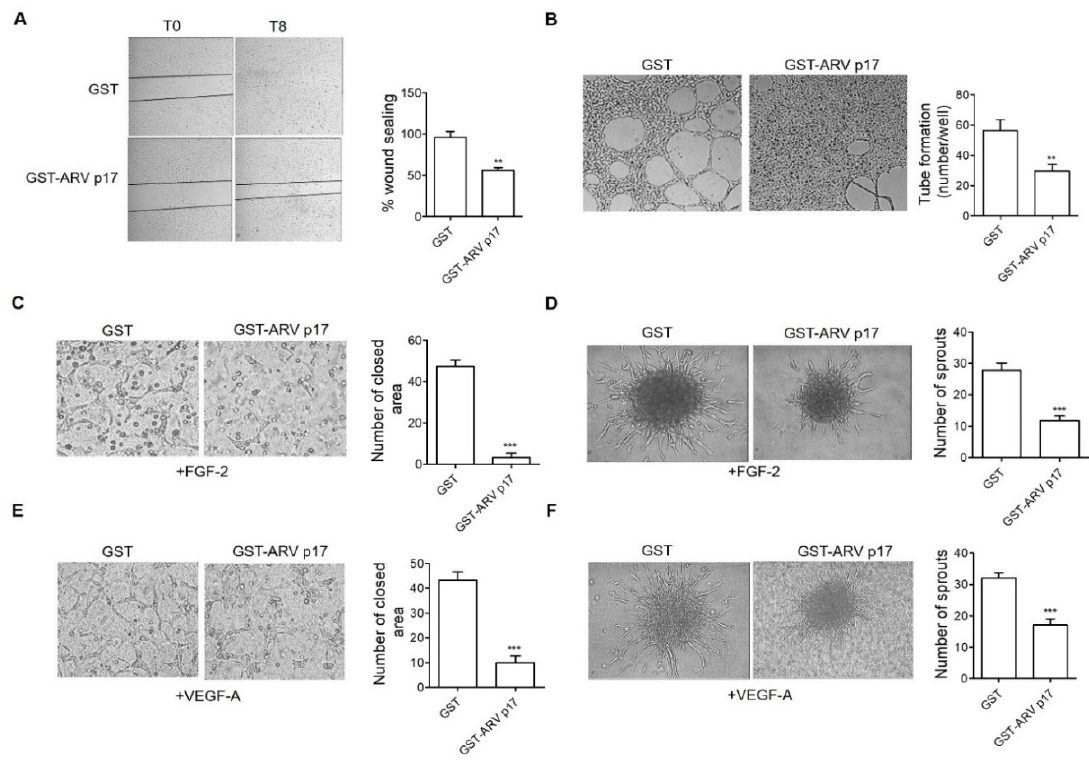
Figure 4. Effect of recombinant Glutathione S-Transferase (GST)-ARV p17 protein on angiogenesis. HUVECs were